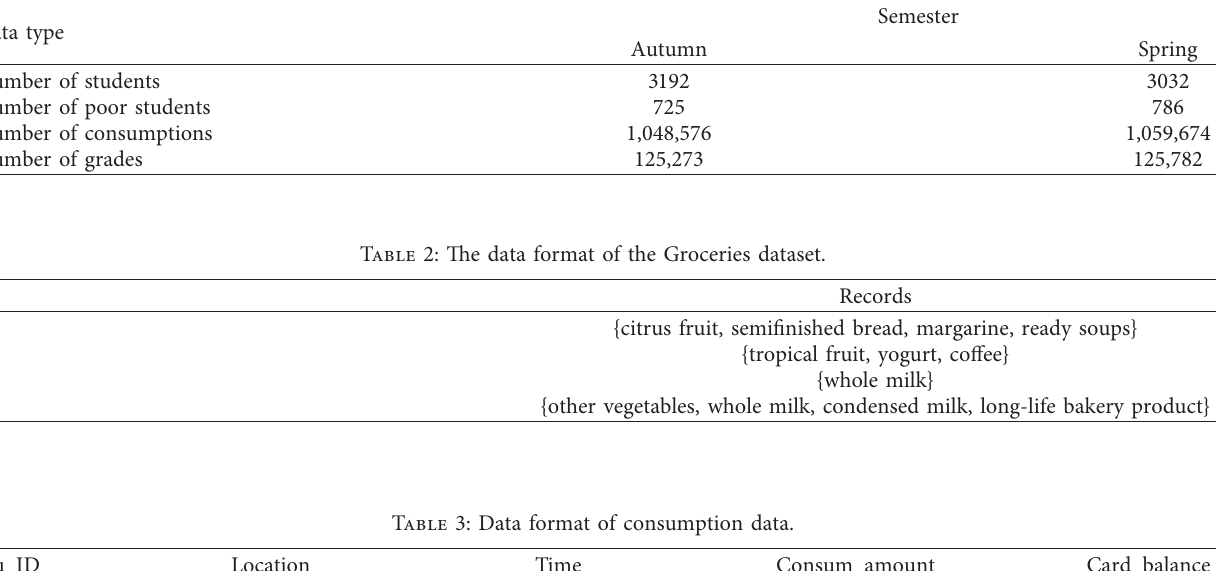
Table 1: Basic statistics of our dataset.